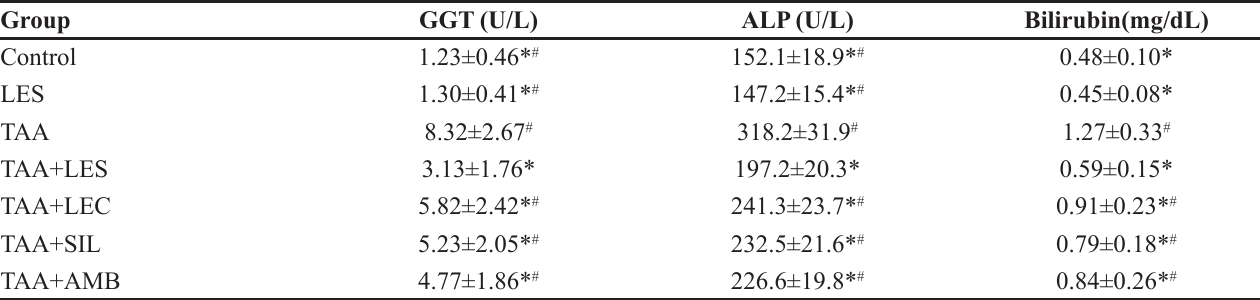
TABLE III - Effect of TAA, lesimarin and its constituents on GGT, ALP activities and bilirubin level